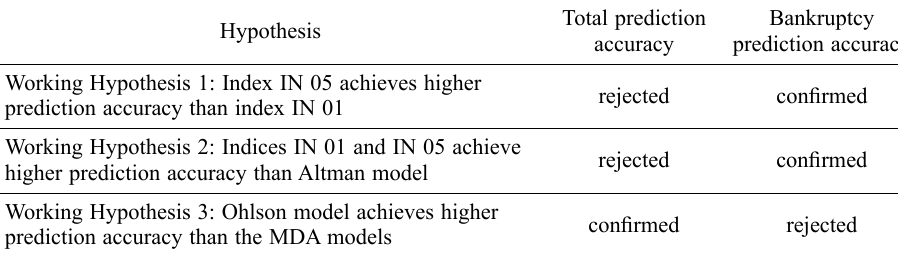
Table 5. Summary of confirmation of working hypothesis Hypothesis